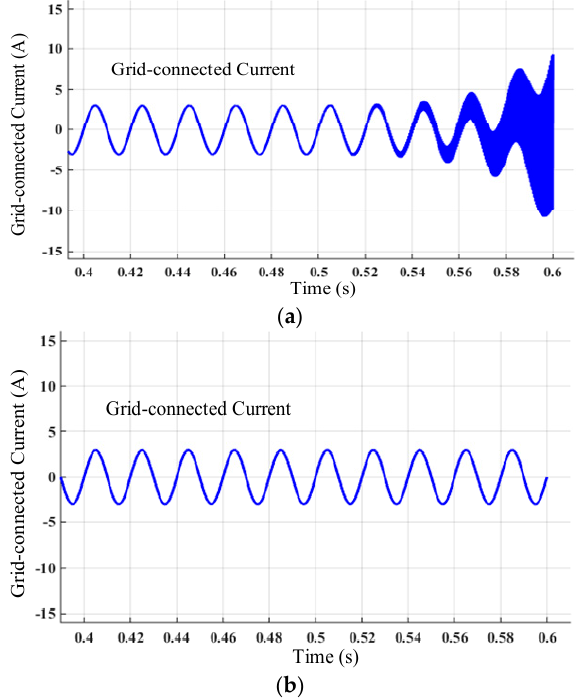
Figure 11. Grid-connected current without or with the additional virtual impedance loop: ( a ) without virtual impedance loop; ( b ) with virtual impedance loop.